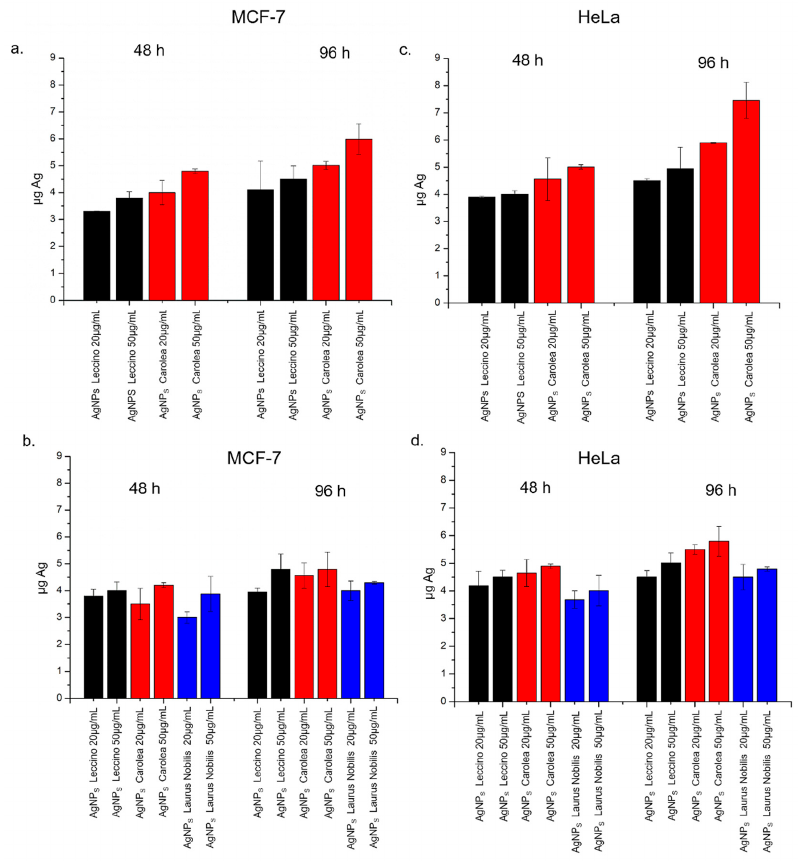
Figure 9. Green AgNPs accumulation in MCF-7 ( a,b ) and HeLa ( c,d ) cell lines exposed to 20 µ g / mL and 50 µ g / mL of AgNPs derived from Leccino and Carolea at pH 7 ( a,c ) and AgNPs from Leccino , Carolea , Laurus Nobilis at pH 8 ( b,d ) for 48 h and 96 h. Cells were then harvested, live cells were counted, and Ag content was measured in 360.000 cells ( μ g Ag). Data reported as mean ± SD from three independent experiments; statistical significance of exposed cells vs. control cells for p value < 0.05 (< 0.05 *).